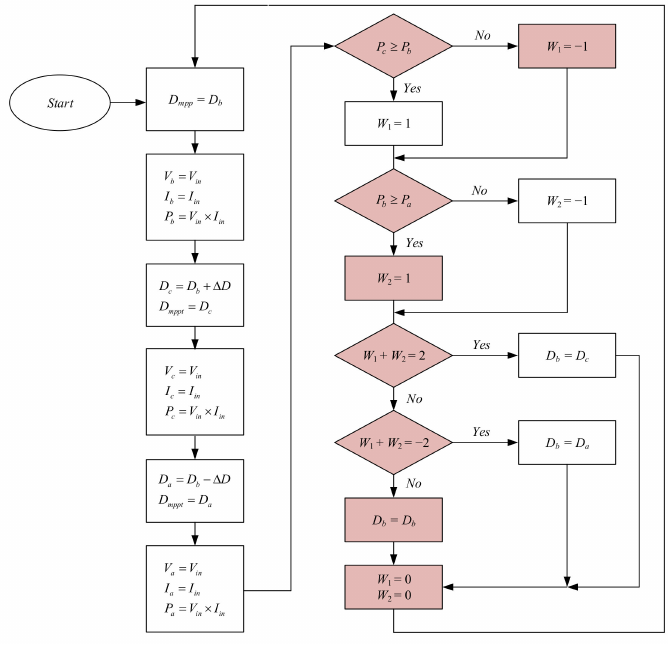
Figure 3. Operating procedure of the three-point weighting strategy for